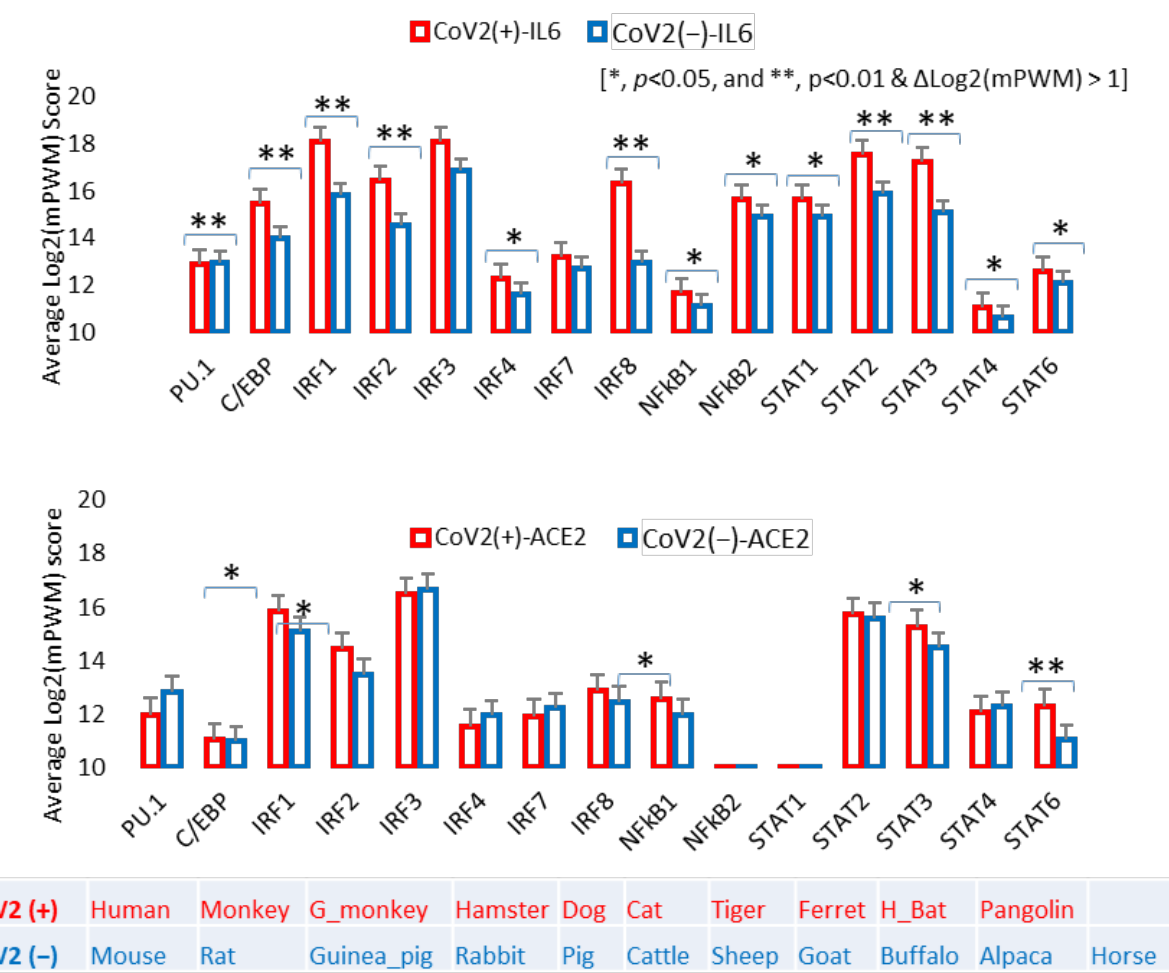
Figure 6. Cross-species correlation of epigenetically regulatory CREs, which associate with inflammatory and IFN signaling, in IL-6 and ACE2 gene promoters as biomarkers for COVID-19 susceptibility. Mean PWM (mPWM) scores were generated as described in previous figures, and compared between two groups of known COVID-19 susceptible species [CoV2(+)] and unsusceptible species [CoV2( − )]. This shows that ACE2, and especially IL-6 genes, from CoV2(+) species contain the CREs which have significantly higher mPWM scores, indicating that in some vertebrate species, non-ISGs such as ACE2 and especially IL-6 genes evolved to obtain high inductive propensity by inflammatory and IFN signaling, and may serve as epigenetic biomarkers (or triggers) for susceptibility prediction of COVID-19 and other ARD syndrome. *, p < 0.05, and **, p < 0.01 and ∆ Log 2 (mPWM) > 1; n = 10, compared between the CoV(+) and CoV( − ) groups. Abbreviation: H_Bat, great horseshoe bat; other abbreviations are as in Figure